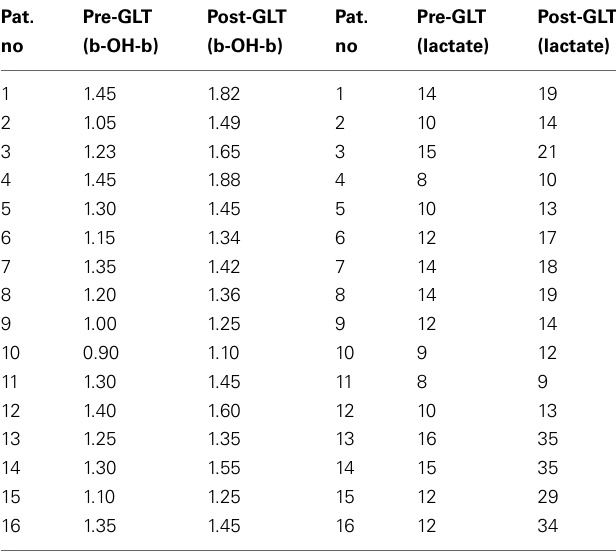
Table 3 | Evaluation of lactate and beta-hydroxybutyrate after glucose loading